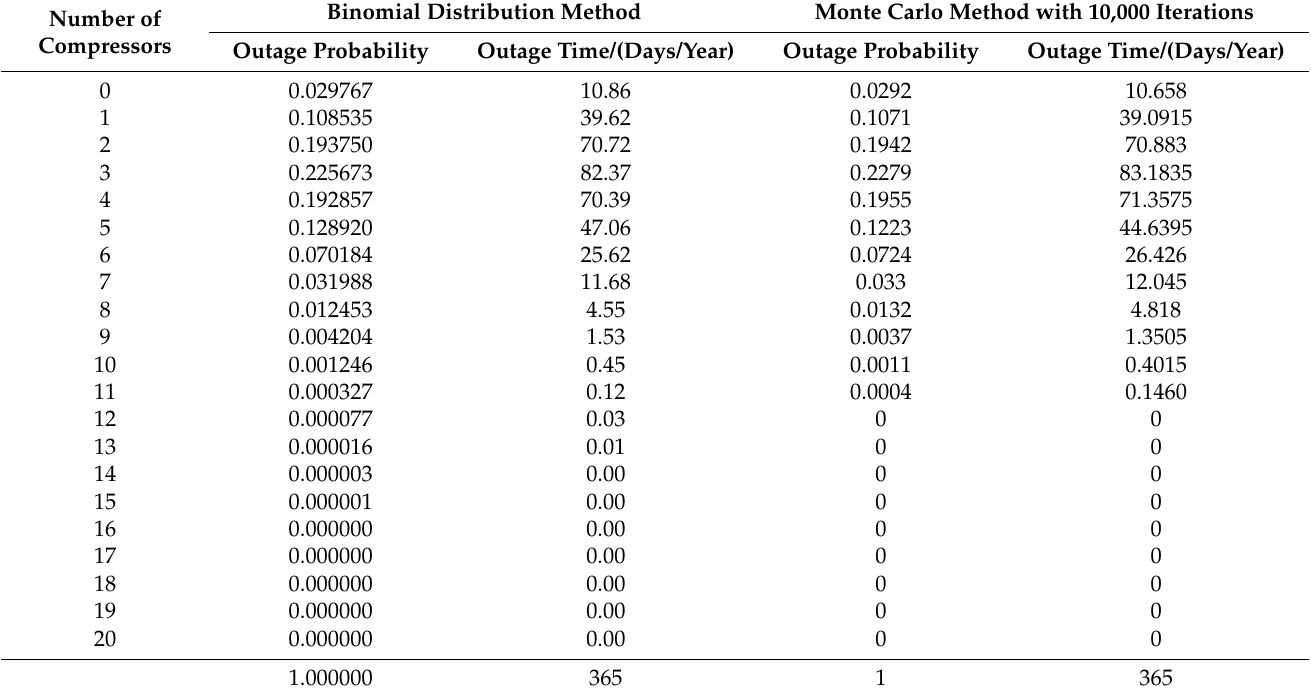
Table 4. Outage probability and time.